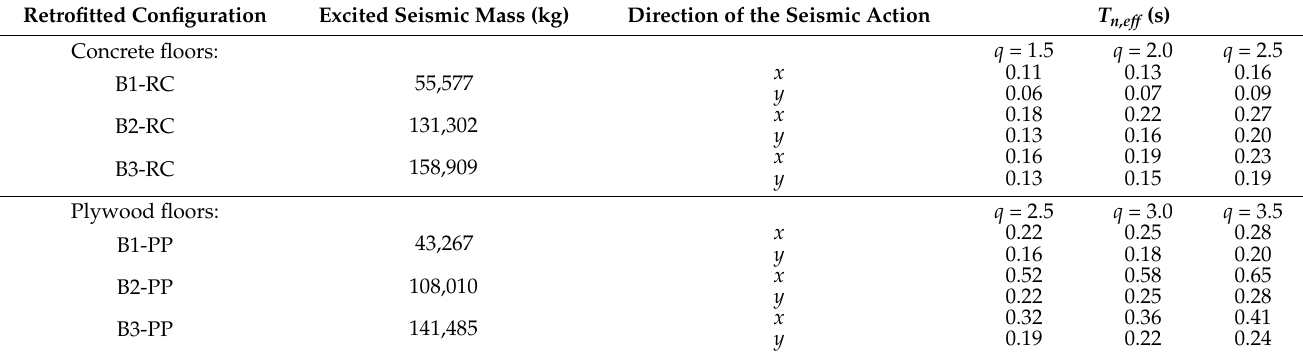
Table 13. Values of the equivalent period for the retrofitted configurations as a function of the behavior factor range. Retrofitted